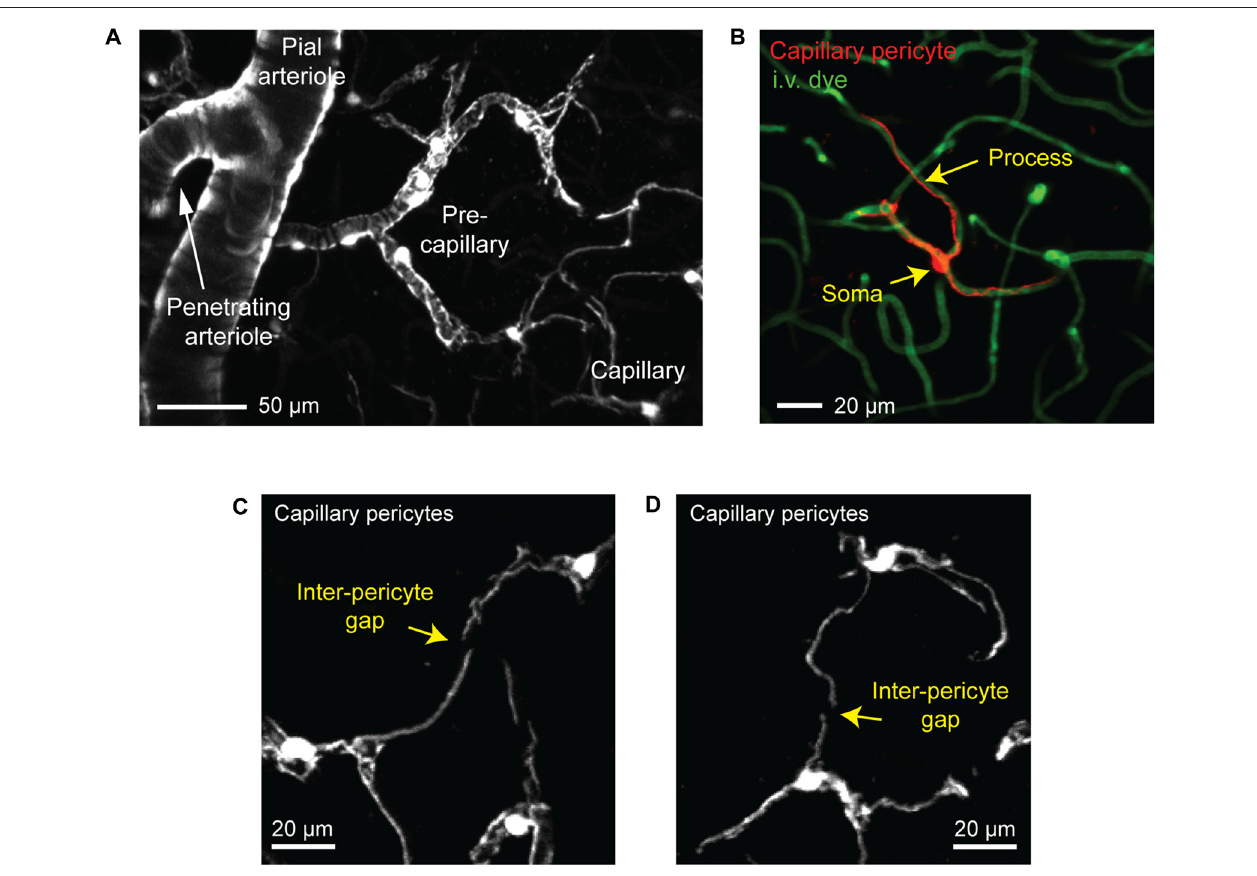
FIGURE 3 | Visualizing capillary pericytes with in vivo two-photon imaging. (A) An in vivo image showing shift in mural cell appearance as a pial arteriole branches into an underlying penetrating arteriole, which then ramifies into the pre-capillary arteriole and capillary bed. The image was captured in the cortex of a Myh11-tdTomato mouse and is a maximal projection over 150 µ m of cortical thickness. (B) In vivo image of an isolated capillary pericyte following intravenous injection of 2 MDa FITC-dextran to co-label the microvasculature. Image was captured from a NG2-tdTomato mouse. (C,D) Examples of the non-overlapping territories of adjacent capillary pericytes from a Myh11-tdTomato mouse. The location of gaps between two pericyte territories are denoted with